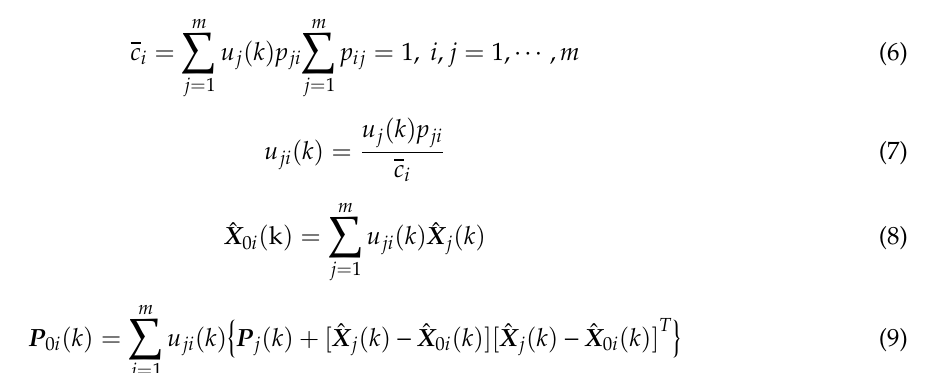
Figure 2. Flow graph of interacting multiple model extended Kalman filter (IMMEKF).